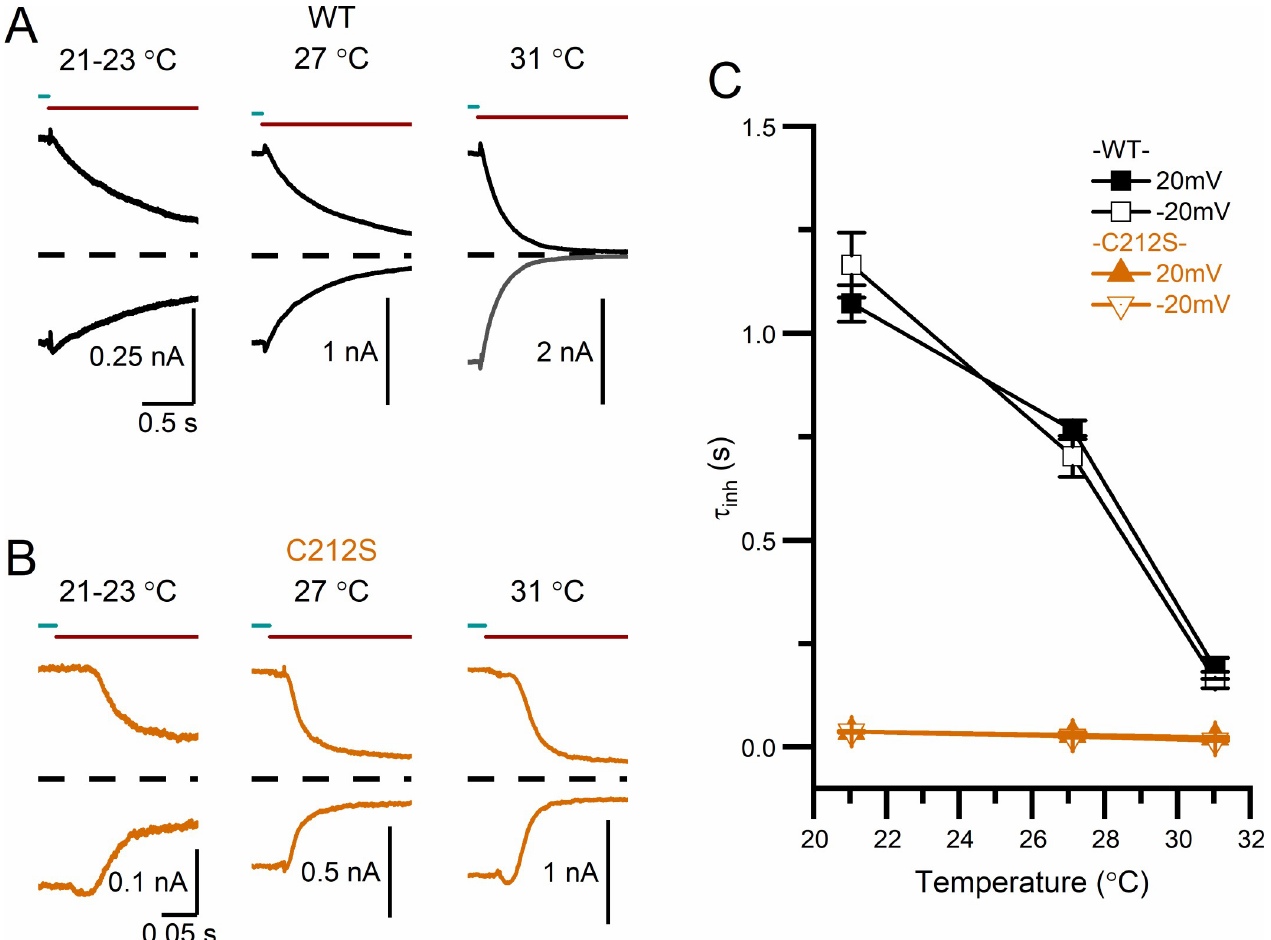
Fig 7. Comparing the temperature dependence of low pH i -induced inhibitions between WT CLC-0 and the C212S mutant. (A) Inhibitions of WT CLC-0 by a solution with pH i = 5.5 at three temperatures. (B) Inhibitions of the C212S mutant by a solution with pH i = 4.5. All recording traces in A & B were obtained at V m = ± 20 mV. (C) Time constants of H + inhibition of WT CLC-0 and the C212S mutant plotted against temperature (n = 5–11).